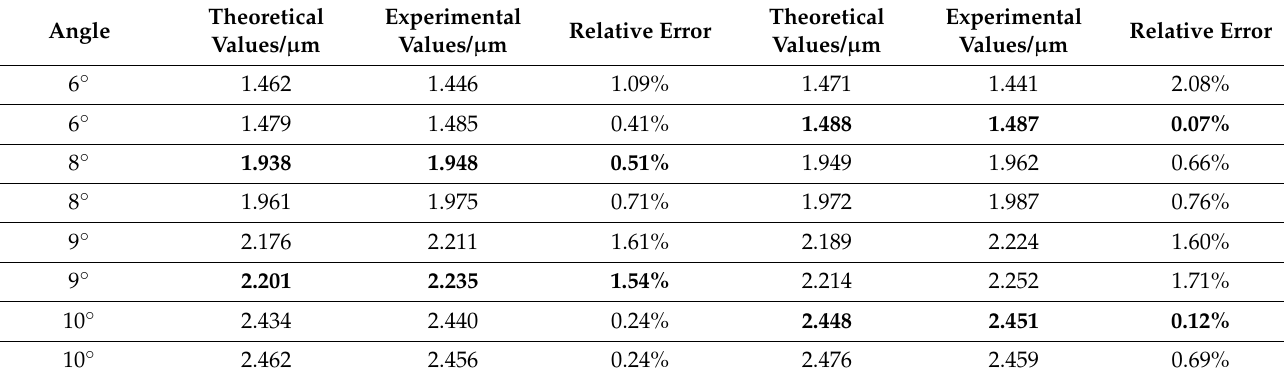
Table 2. Theoretical results and experimental results by DSCM in Figure 7 at y =